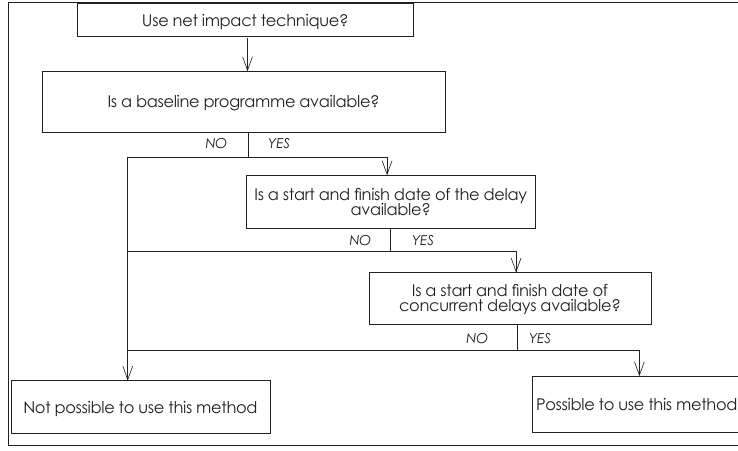
Figure 12: Decision tree: Net impact technique?